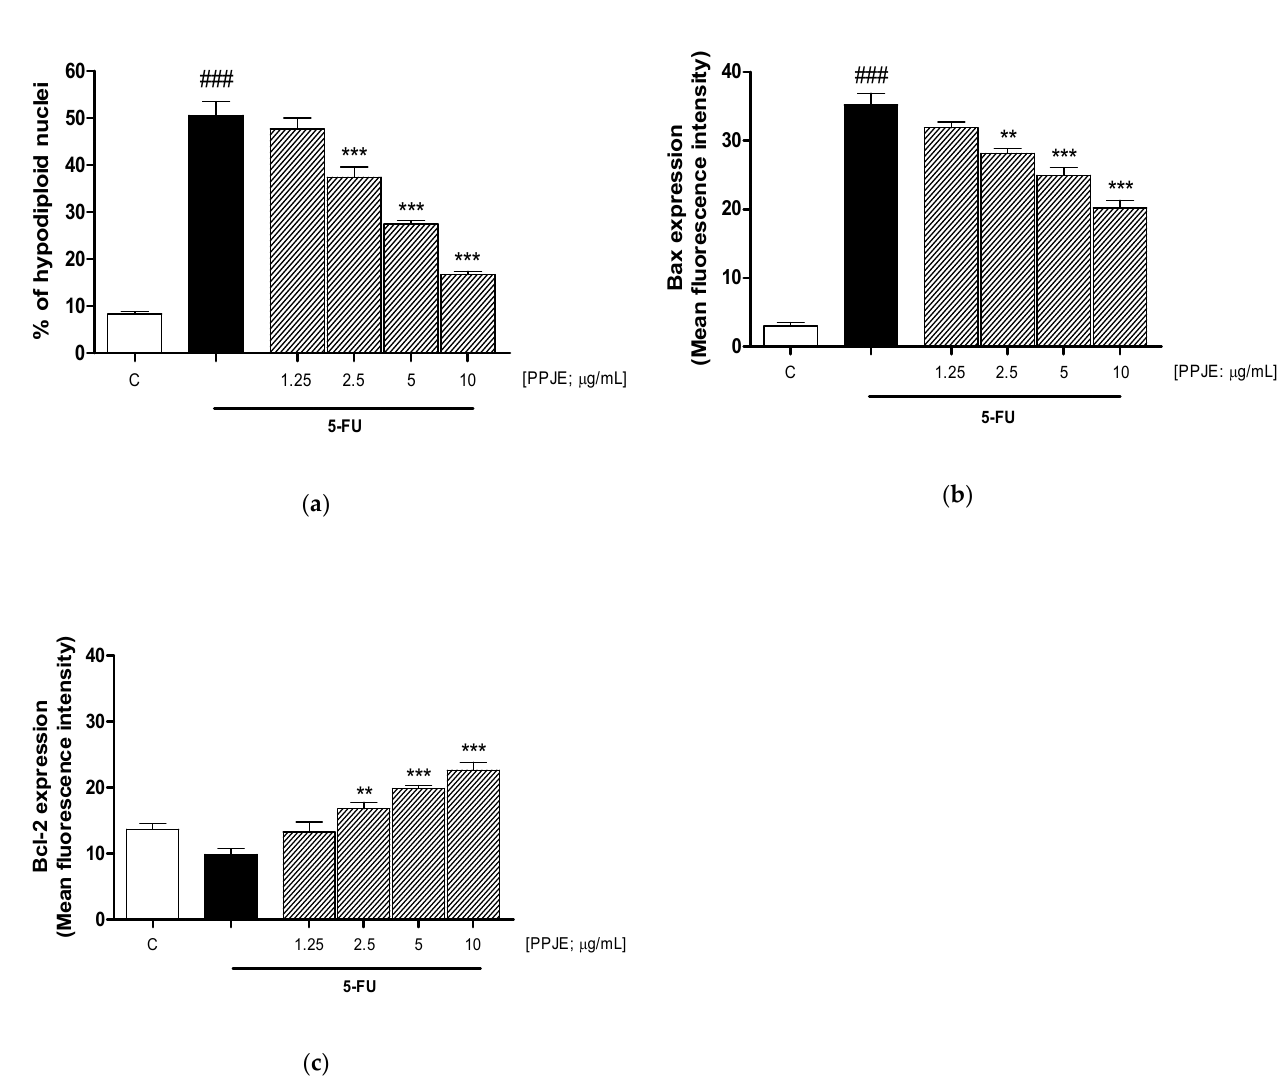
Figure 5. Effect of pomegranate juice extract (PPJE; 1.25–10 µg/mL) on apoptosis ( a ), evaluated by propidium iodide assay, and on Bax ( b ) and Bcl-2 ( c ), evaluated by cytofluorimetric technique, on HaCaT cells treated with 5-fluorouracil (5-FU; 10 µg/mL). Data are expressed as % of hypodiploid nuclei or as mean of fluorescence intensity. C denotes control group. ### denotes p < 0.001 vs. C; *** and ** denote respectively p < 0.001 and p < 0.01 vs. 5-FU.